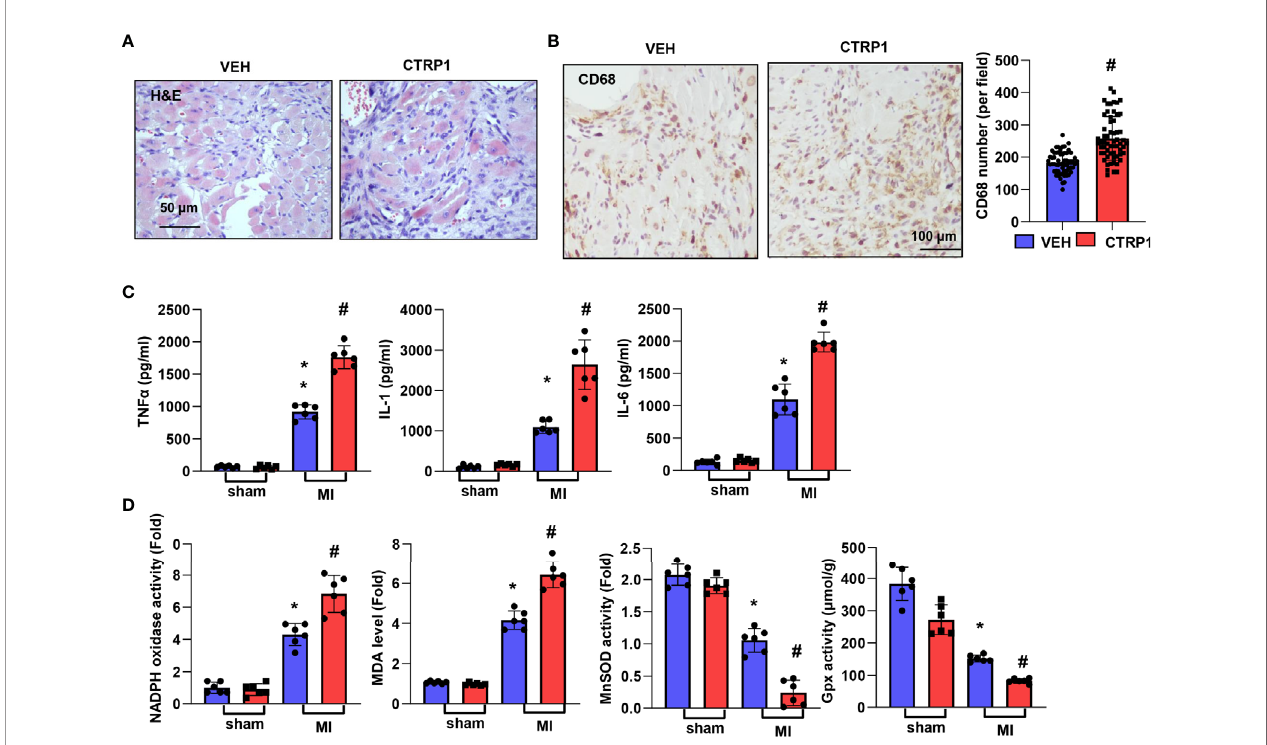
FIGURE 5 | Human recombinant CTRP1 enhances cardiac in fl ammation and OS post MI. (A) H&E staining. (B) CD68 staining and quanti fi cation of the results in mice receiving the human recombinant CTRP1 protein at 28 days post MI (n=6 per group). (C) In fl ammatory cytokine levels in heart tissue post MI (n=6 per group). (D) Oxidase and anti-oxidase activities and MDA levels in heart tissue post MI (n=6 per group). * P <0.05 vs. the VEH-sham group. # P <0.05 vs. the VEH-MI